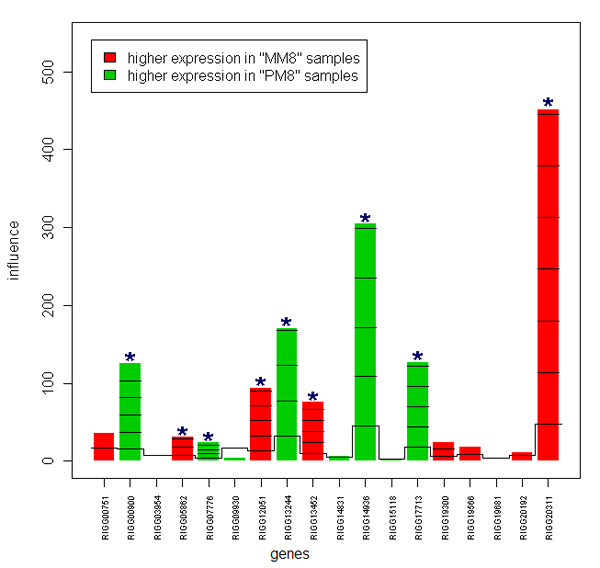
Geneplot of the GO term "ruffle". The gene plot shows a bar and a reference line for each gene tested. The reference line reflects the expected influence if the gene was not associated with the GO term "ruffle". In case the height of the bar exceeds the reference line, the gene significantly influences the GO term "ruffle". Marks indicate the standard deviations by which the bar exceeds the reference line. The bars are coloured to indicate a higher expression in PM8 compared to MM8 (green) or a higher expression in MM8 compared to PM8 (red). * Genes clearly above the reference.